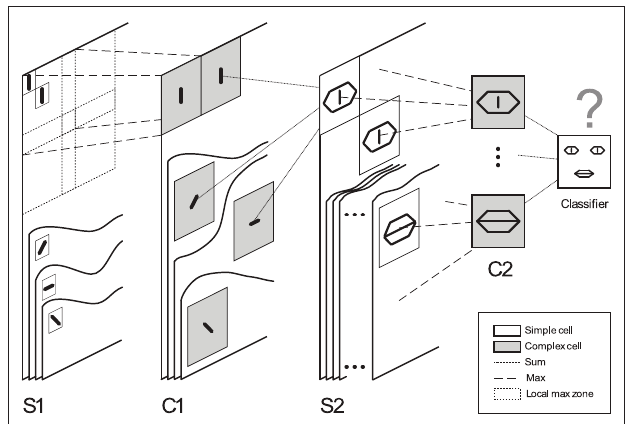
Figure 1 | Overview of the five layer feed forward spiking neural network used in Masquelier and Thorpe, 2007. As in HMAX (Riesenhuber and Poggio, 1999; Serre et al., 2007), we alternate simple cells that gain selectivity through a sum operation, and complex cells that gain shift and scale invariance through a max operation (which in our framework simply consists of propagating the first received spike). Cells are organized in retinotopic maps until the S2 layer (inclusive). S1 cells detect edges. C1-maps subsample S1-maps by taking the maximum response over a square neighborhood. S2 cells are selective to intermediate complexity visual features, defined as a combination of oriented edges (here, we symbolically represented an eye detector and a mouth detector). There is one S1–C1–S2 pathway for each processing scale (not represented). Then C2 cells take the maximum response of S2 cells over all positions and scales, and are thus shift- and scale-invariant. Finally, a classification is done based on the C2 cells’ responses (here we symbolically represented a face/non-face classifier). In the brain, equivalents of S1 cells may be in V1, S2 cells in V1–V2, S2 cells in V4– PIT, C2 cells in AIT, and the final classifier in PFC. Here STDP shapes the C1-to-S2 connectivity. Figure 2 shows an example of resulting selectivities after exposing the network to face images. Figure modified from Masquelier and